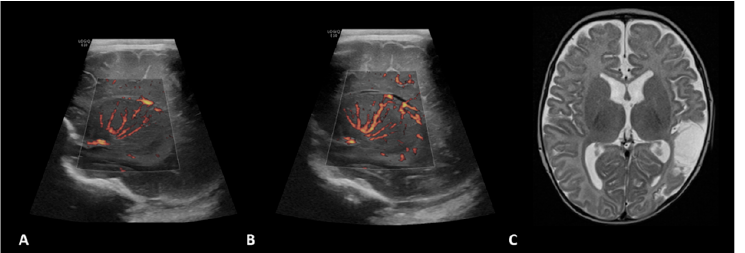
Figure 1. A 1.5-month-old girl with a history of transposition of the great arteries (TGA) underwent ECMO due to failure to wean from cardiovascular bypass after major cardiac surgery. Brain MVI was performed after three days from cannulation; grayscale US (not shown) demonstrated a small focus of increased echogenicity within the left caudate. Right ( A ) and left ( B ) parasagittal brain MVI showed mild bilateral tortuosity of the lenticulostriate vessels. The patient remained on ECMO for a total of four days and presented with seizures two days after decannulation, secondary to a cardioembolic stroke in the territory of the posterior left middle cerebral artery, as shown in axial T2-weighted MRI ( C ) obtained two months later.